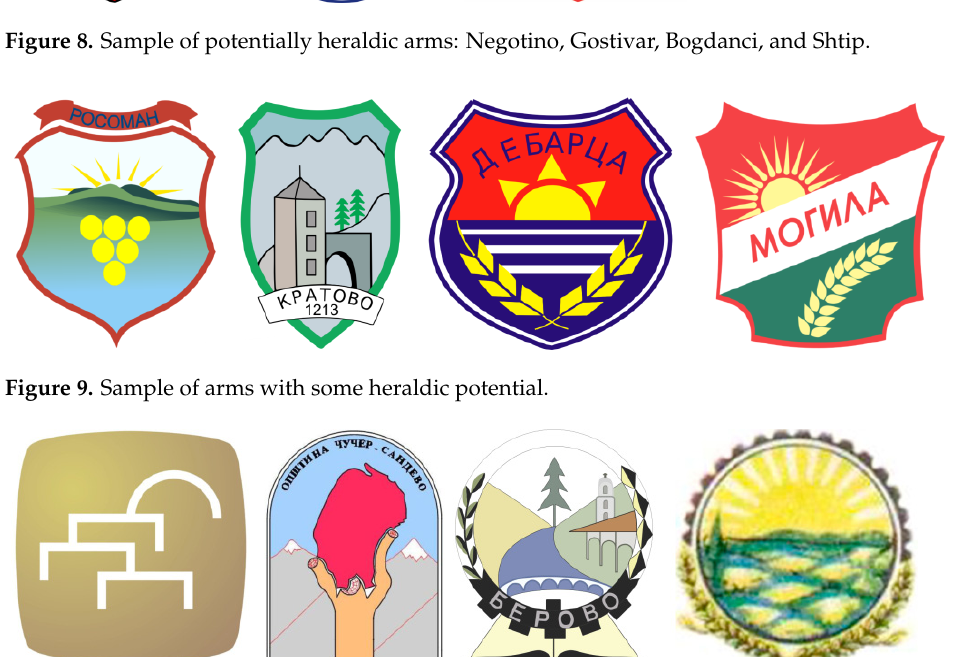
Figure 10. Sample of emblems impossible to consider heraldic.